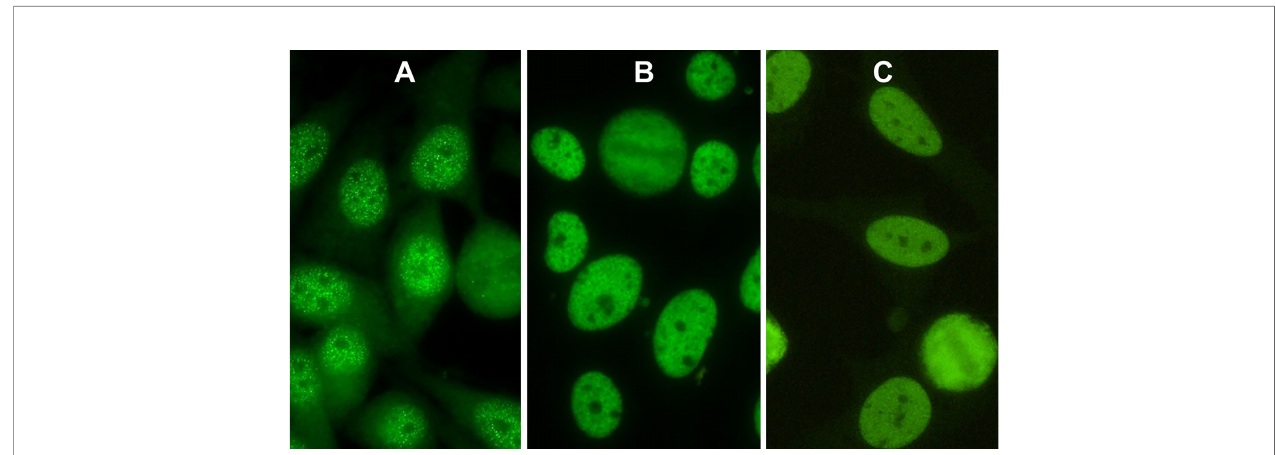
FIGURE 1 | Indirect immuno fl uorescence pictures of HEp-2 cells. (A) Nuclear pattern of antibodies against Ro60 (AC-4a). (B) AC-4b pattern caused by antibodies against Mi-2. (C) AC-4 mixed pattern of antibodies against Ro60 and antibodies against